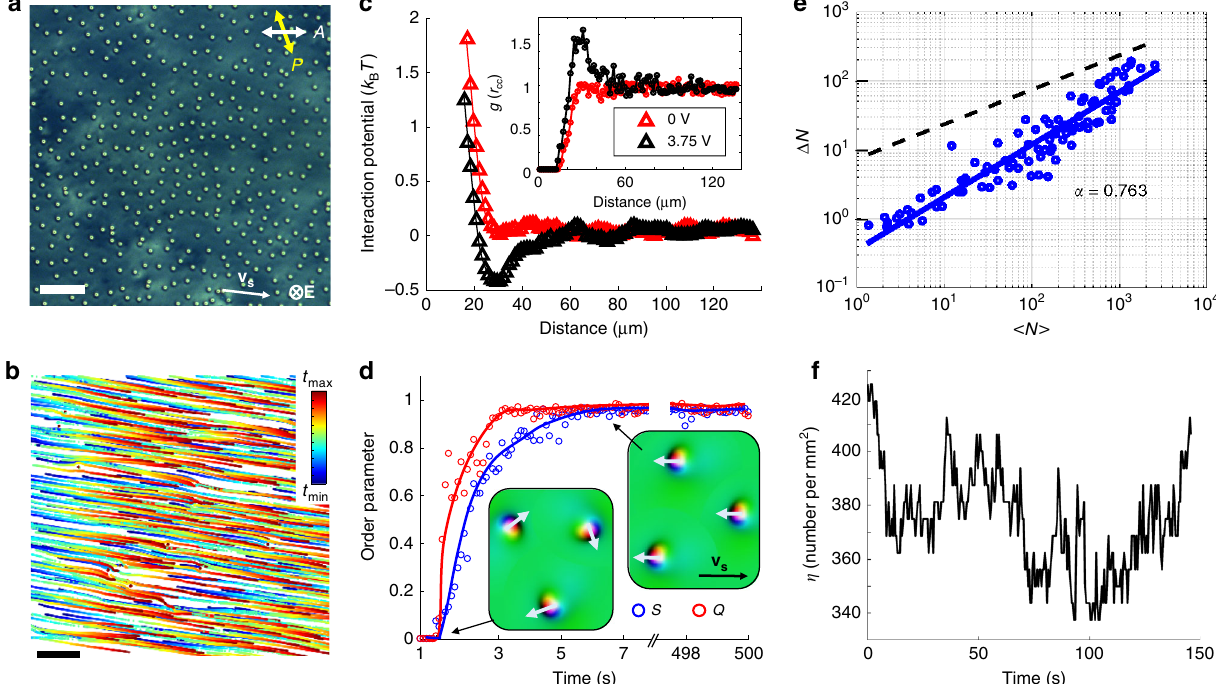
Fig. 4 Coherent skyrmion motion in a school. a Experimental polarizing micrograph of moving skyrmions in a school without clustering for initial packing fraction of 0.09 by area at U = 3.75 V and f = 50 Hz. Polarizer and analyzer orientations are marked with double arrows and directions of E and skyrmion motion are marked in the bottom-right corner. b Trajectories of skyrmion motions color-coded with time according to the scheme shown in the right-side inset (where t min = 0 and t max = 72 s); these trajectories correspond to Supplementary Movie 5. The scale bars in a , b are 100 µ m . c Interaction potential (extracted from the radial distribution function g ( r cc ) shown in the inset) of center-to-center distances r cc for schooling skyrmions at conditions like in a . d Evolution of S and Q with time. Insets schematically show corresponding con fi gurations colored according to the scheme in the inset of Fig. 1g. e Giant- number fl uctuation analysis using a log – log plot of Δ N versus < N >; black dashed line indicates a slope of 0.5 for reference. f An example of number density fl uctuation during motion for a 400 µ m × 400 µ m sample area. Such schools of individually dispersed, collectively moving skyrmions are observed at U = 2.5 – 4.25 V and initial packing fractions within 0.01 – 0.09 by area. The LC is ZLI-2806 doped with right-handed additive CB-15 (see